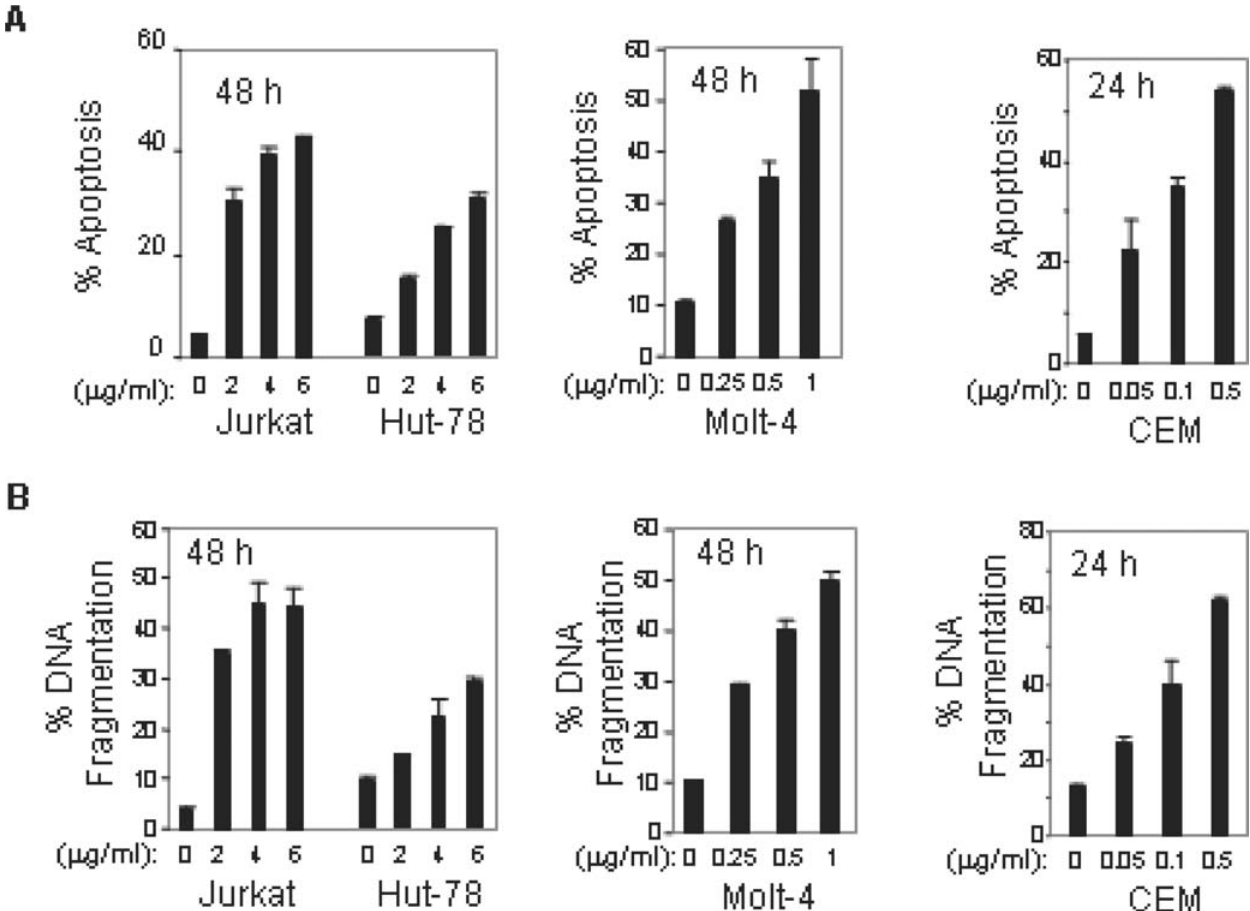
Figure 1. ART induces apoptosis in malignant T cells. Jurkat, Hut-78, Molt-4 and CEM leukemic T cells were incubated with different doses of ART for 24 or 48 h as indicated. The apoptotic cell death was determined either by FSC/SSC index for changes in cell size and granularity (A) or by DNA fragmentation (B). Results are representative of three independent experiments determined in triplicates.